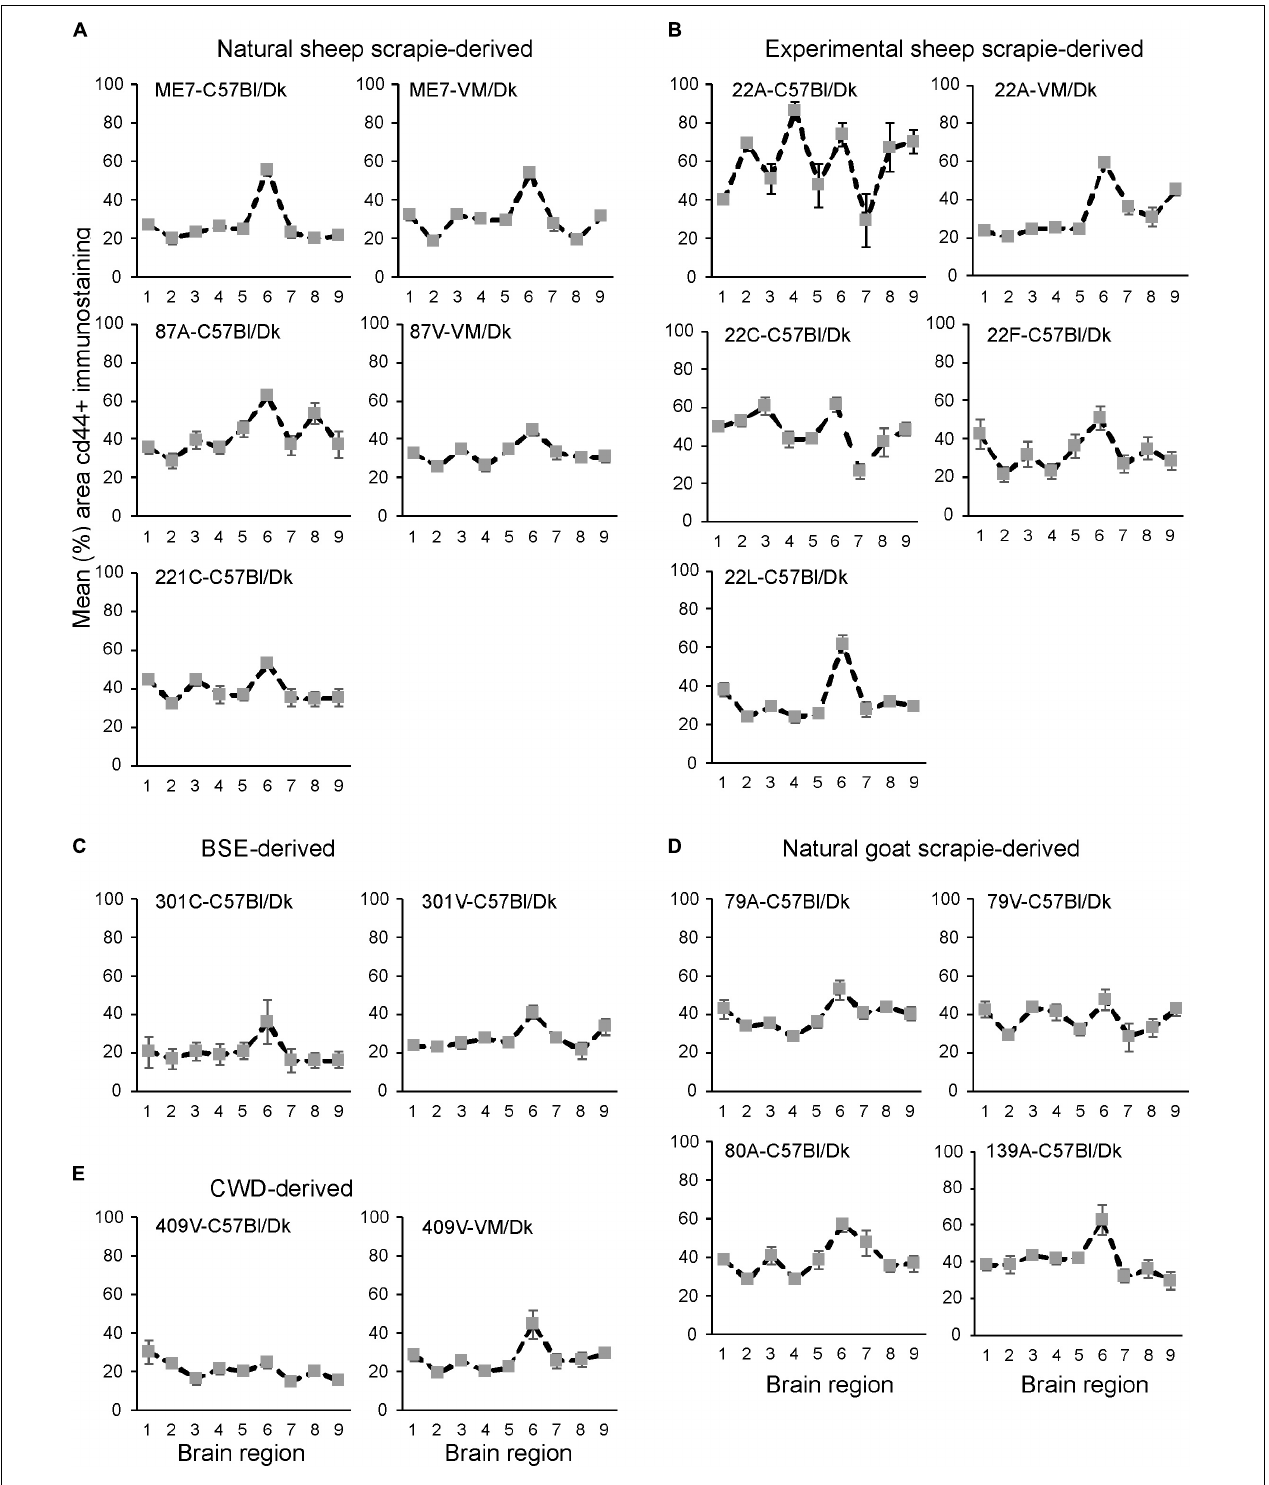
FIGURE 9 | (A–E) Comparison of the magnitude and distribution of the CD44 + immunostaining in the brains of mice infected with a variety of distinct prion agent strains. Groups of C57Bl/Dk or VM/Dk mice were injected intracerebrally with a variety of distinct prion agent strains ( Table 1 ). Brains were collected at the terminal stage of disease and immunostained to detect CD44. The percentage area coverage of CD44 + immunostaining was then compared in each of the following gray matter brain regions G1, dorsal medulla; G2, cerebellar cortex; G3, superior colliculus; G4, hypothalamus; G5, medial thalamus; G6, hippocampus; G7, septum; G8, cerebral cortex; G9, forebrain cerebral cortex. N = 6 mice/group. Data represent mean ± SEM, from a minimum of 54 images/group.